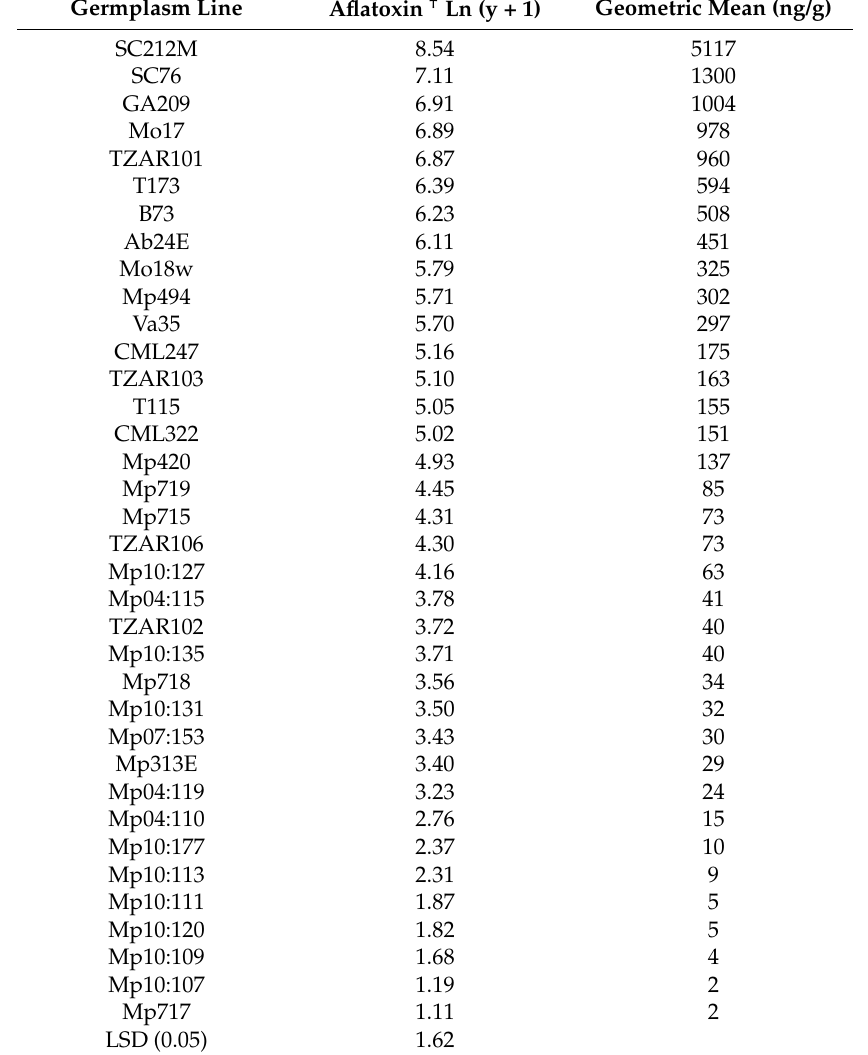
† Plot means for aflatoxin concentration were transformed (Ln (y + 1), where y = concentration of aflatoxin in a sample) before statistical analysis. Geometric means were calculated by reverse transformation of logarithmic means back to the original units of